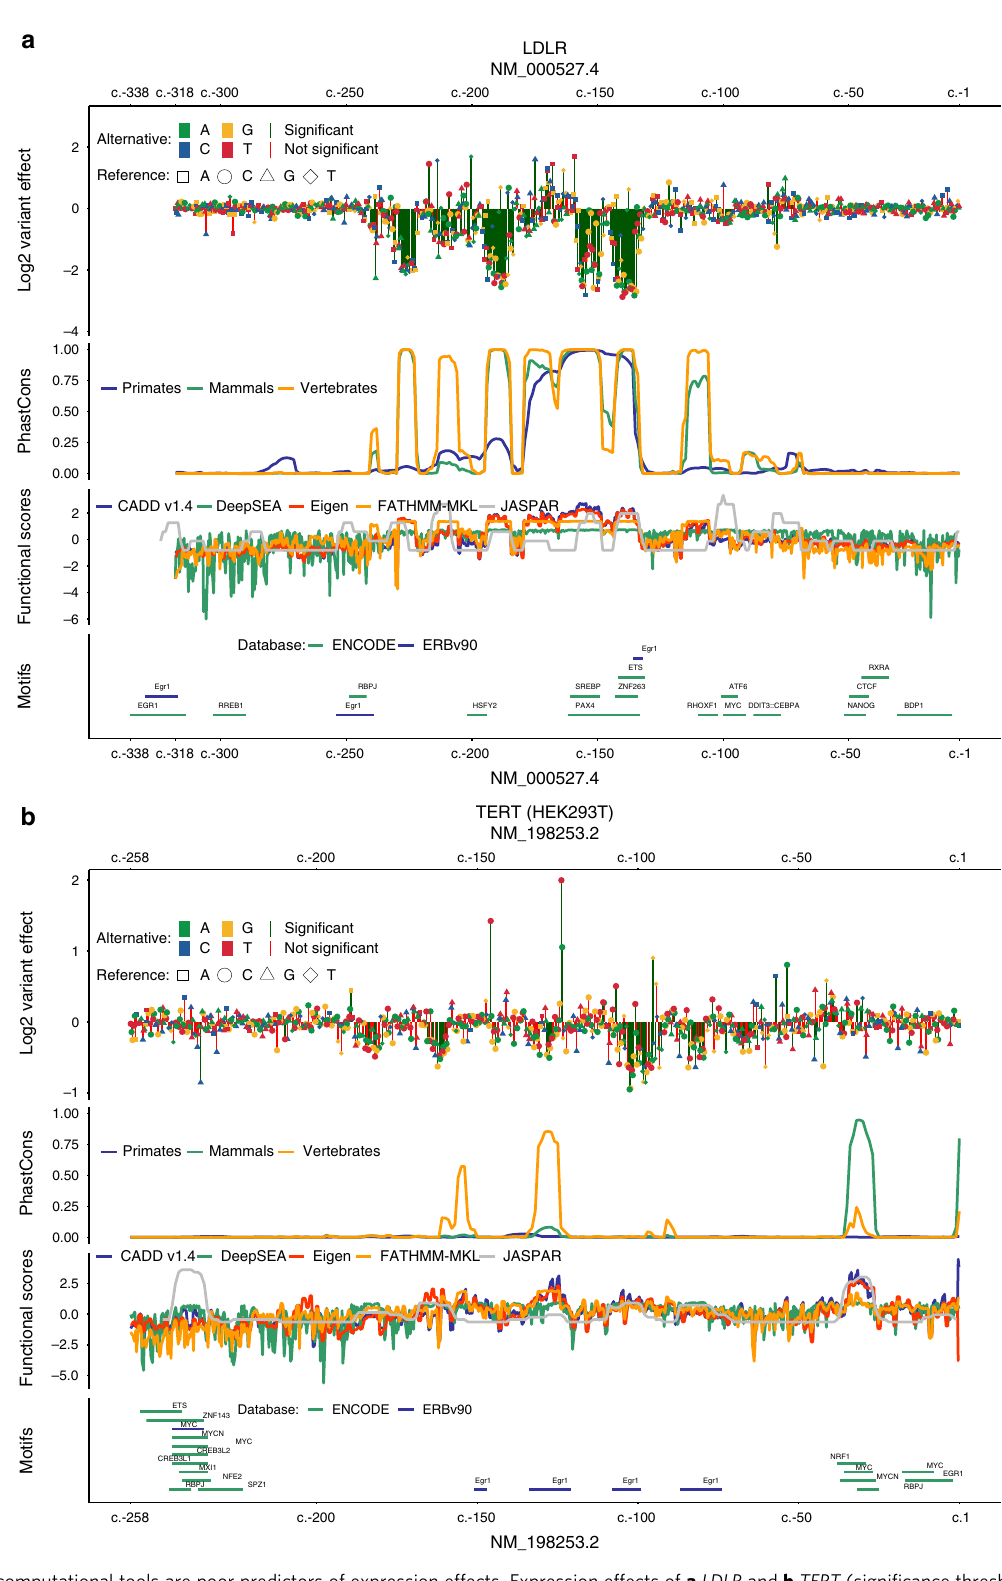
Fig. 4 Current computational tools are poor predictors of expression effects. Expression effects of a LDLR and b TERT (signi fi cance threshold 10 − 5 ; red vs. green vertical lines) compared with PhastCons 68 conservation scores, combined scores of functional genomics data (CADD v1.4 70 , DeepSEA 11 , Eigen 12 , FATHMM-MKL 13 , and number of overlapping 10th percentile scoring JASPAR 60 motifs), and annotated motifs by ENCODE 72 and Ensembl Regulatory Build (ERB) v90